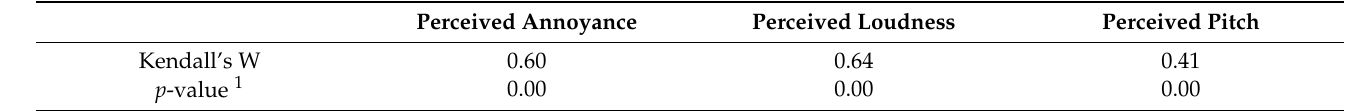
Table 2. Results of the Kendall’s W statistic for the responses on perceived annoyance, loudness and pitch. Perceived Annoyance Perceived Loudness Perceived Pitch Kendall’s W 0.60 0.64 0.41 0.00 0.00 0.00